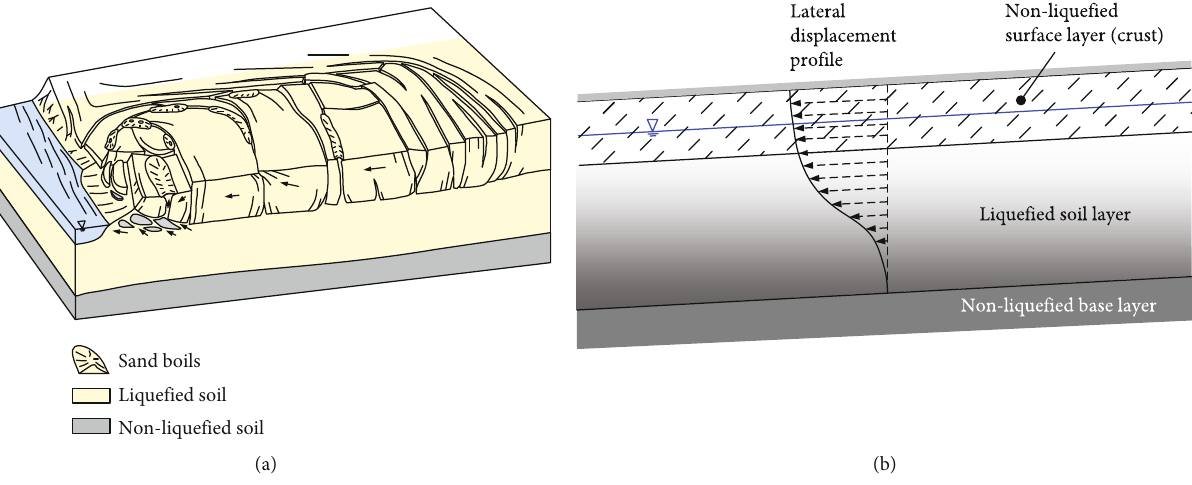
Figure 1: Liquefaction-induced lateral spreading. (a) Schematic depiction. (b) Lateral displacement pro fi le. (After